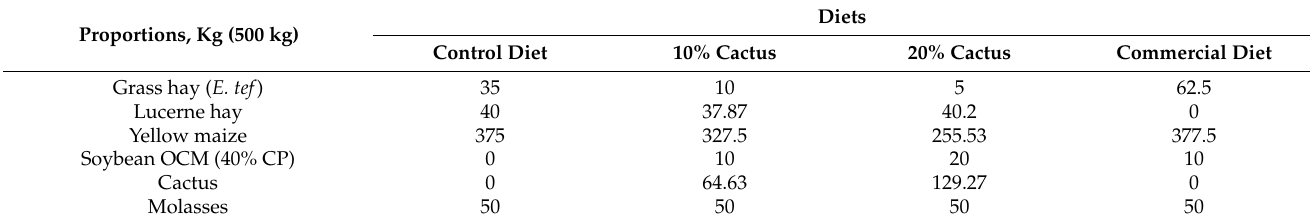
Table 1. The inclusion levels of ingredients in the experimental